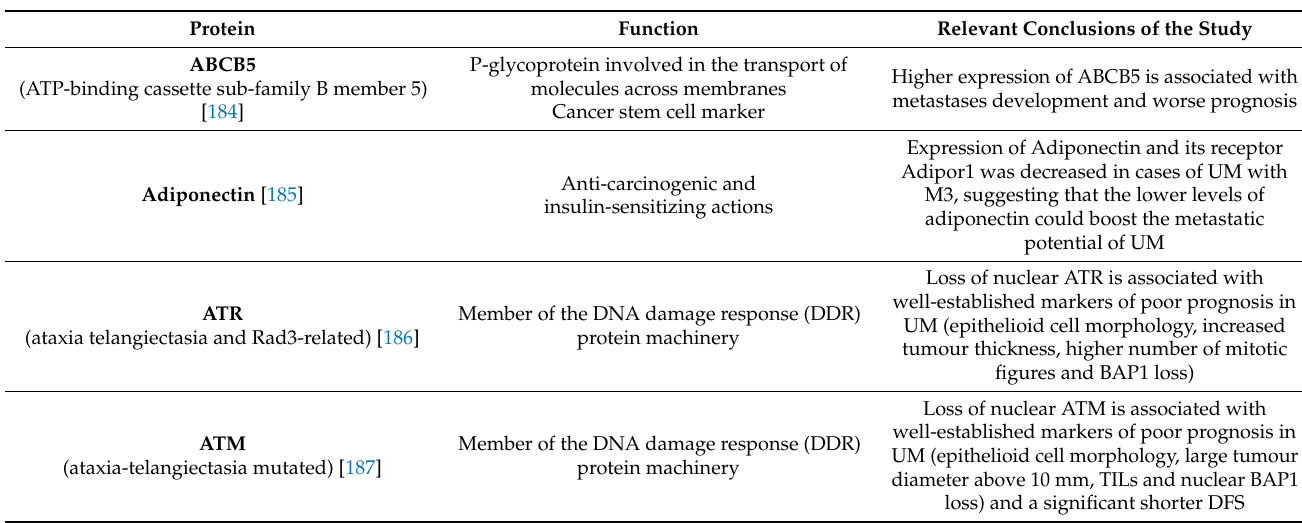
Table 4. Novel promising prognostic immunohistochemistry-based biomarkers in primary uveal melanoma. The new prognostic markers for uveal melanoma highlighted below were published in the past three